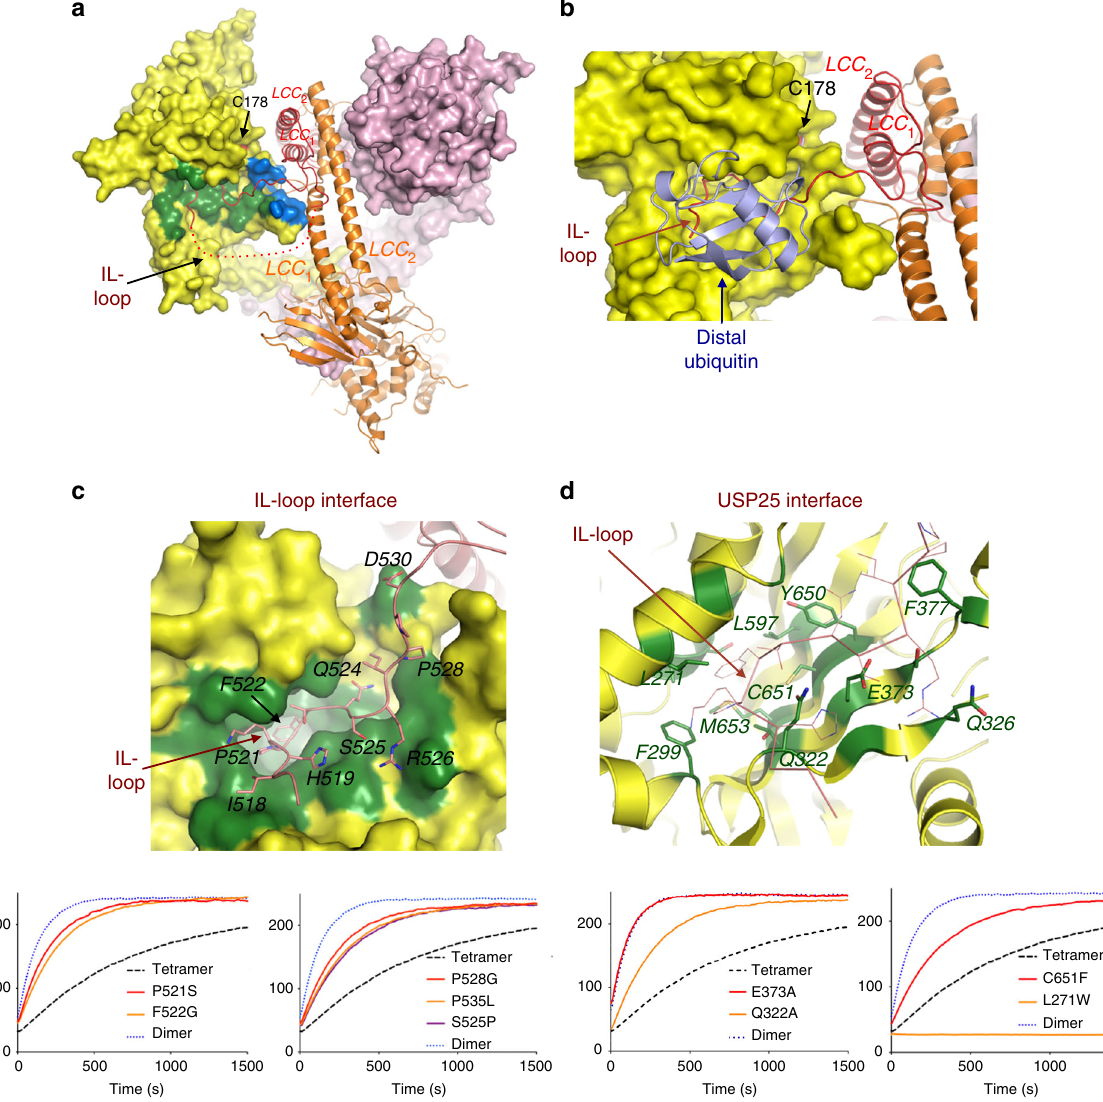
Fig. 4 IL-loop contacts the catalytic domain of USP25 in the tetramer. a Surface and cartoon representation of interface between the IL-loop domain (green), “ kink ” region (blue), and the catalytic domain in the tetramer assembly. b Structure overlapping of USP25 and USP7 structures (PDB code 5JTJ), depicting the S1 ubiquitin-binding domain in contact with either ubiquitin in complex with USP7 structure (light blue) or with the IL-loop domain in the USP25 tetramer (red ribbon). c Surface representation of the S1 ubiquitin-binding pocket (green) of the USP25 catalytic domain in complex with the IL-loop insertion with labeled residues depicted in stick representation. d Cartoon representation of the IL-loop binding interface with labeled residues depicted in stick representation (green). IL-loop is depicted as a thin line (red). e Deubiquitinating activity assays with Ub-AMC substrate of either USP25 wild-type and IL-loop point mutants: puri fi ed tetramer and dimer, P521S, F522G, S525P, P528G, and P535L ( fi rst and second panel); or USP25 wild-type and S1 ubiquitin-binding residues point mutants: E373A, Q322A, L271W, and C651F (third and fourth